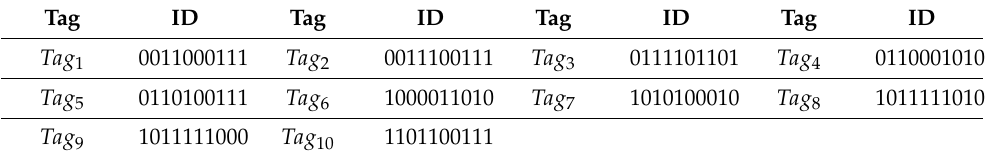
Table 4. Tags’ ID information.